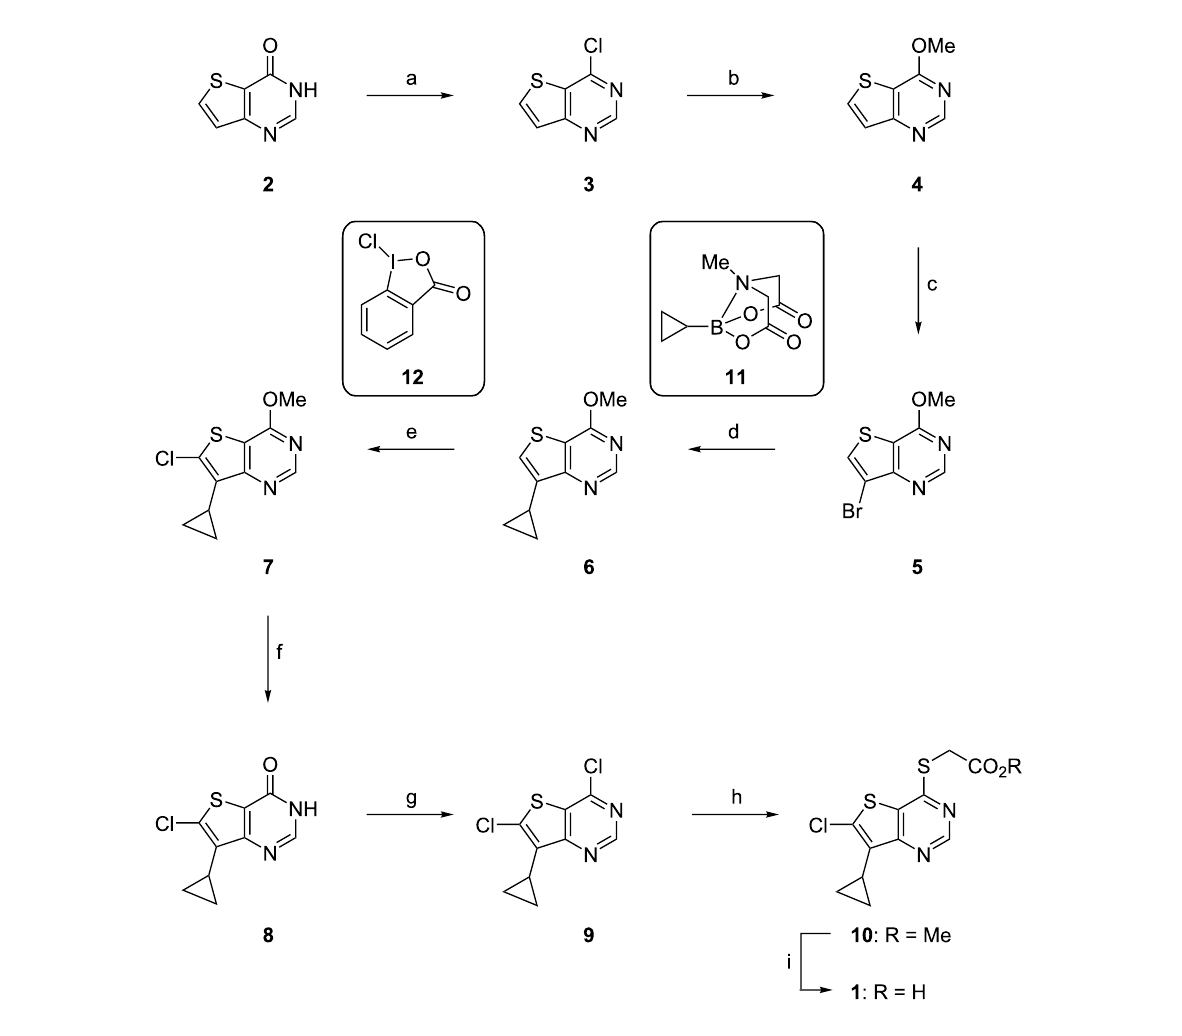
Scheme 1: Synthesis of LP-922056 ( 1 ). Reagents and conditions a : (a) (COCl) 2 (3.3 equiv), DMF, CH 2 Cl 2 , 55 °C , 16 h, 63–78%; (b) NaOMe (5 equiv), 1,4-dioxane, 0 °C then rt, 16 h, 92–93%; (c) NBS (1.1 equiv), AcOH/MeCN (1:100), 85 °C, 16 h, 41–48%; (d) 11 (1.5 equiv), Pd(PPh 3 ) 2 Cl 2 (5 mol %), K 3 PO 4 (6 equiv), PhMe/H 2 O (3:1, 0.25 M), 100 °C, 16 h, 94–95%; (e) 1-chloro-1,2-benziodoxol-3-one ( 12 , 1.5 equiv), DMF, 50 °C, 16 h, 77–94%; (f) HCl (12 M, 40 equiv), 70 °C, 16 h; (g) POCl 3 (20 equiv), 90 °C, 16 h, 81% over 2 steps; (h) HSCH 2 CO 2 Me ( 13 , 1.2 equiv), NEt